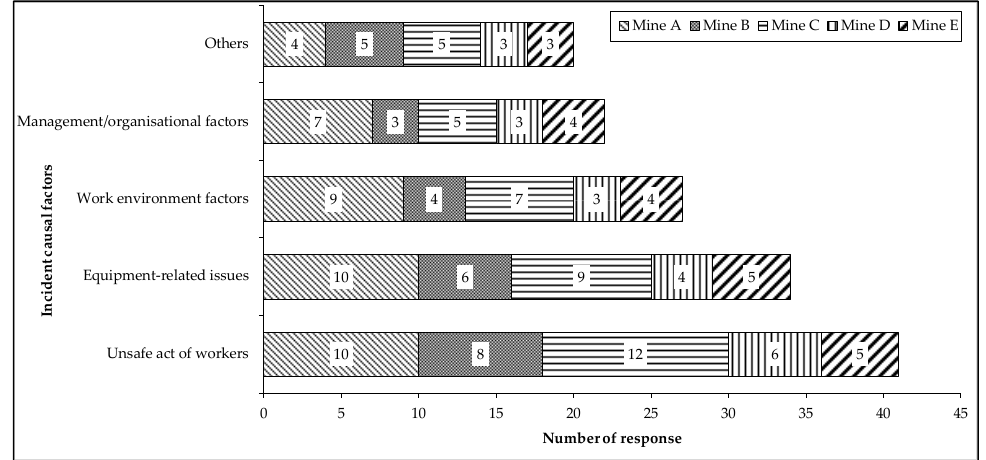
Figure 2. Comparison across mines of incident causal factors.